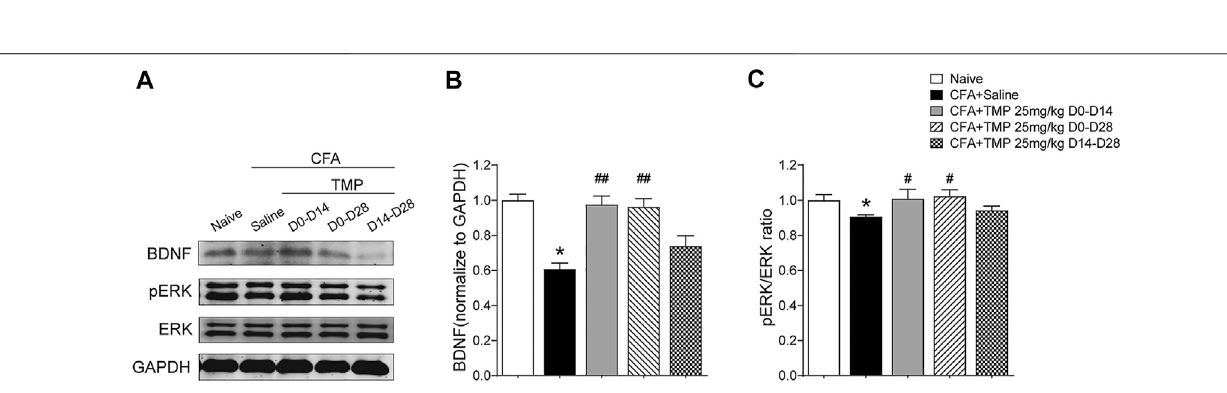
FIGURE 9 | Time course of hippocampal BDNF-ERK expression after CFA injection. (A – C) Levels of hippocampal BDNF (B) and pERK/ERK ratio (C) by western blot testing after CFA injection. Statistical analysis was performed by one way ANOVA, followed by Dunnett ’ s multiple comparisons (* p < 0.05, ** p < 0.01, vs. Day 0).